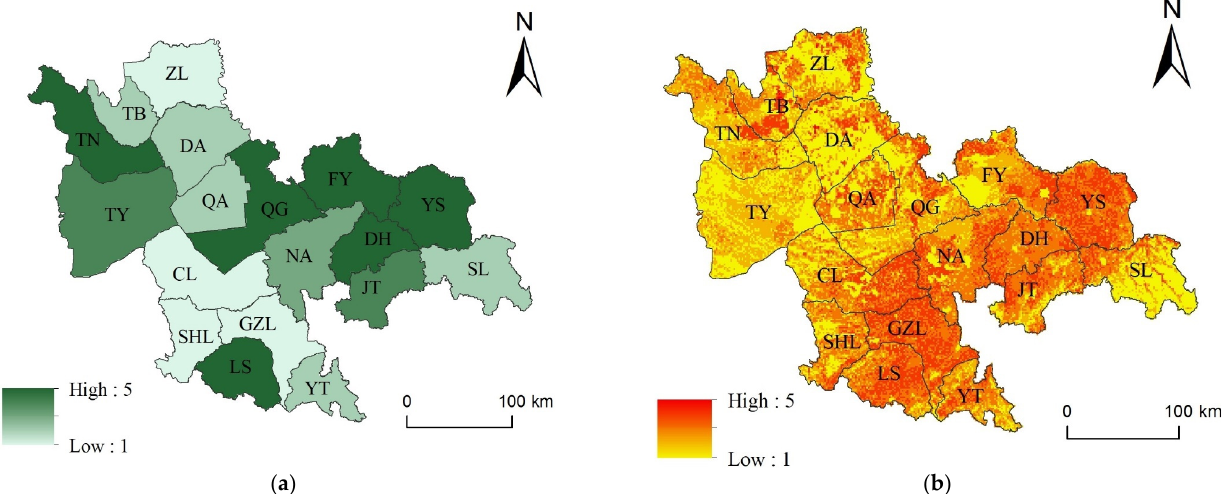
Figure 8. Distribution of different disaster-bearing bodies factor: ( a ) distribution of agricultural drought disaster recurrence levels; ( b ) distribution of exposure levels of agriculture.